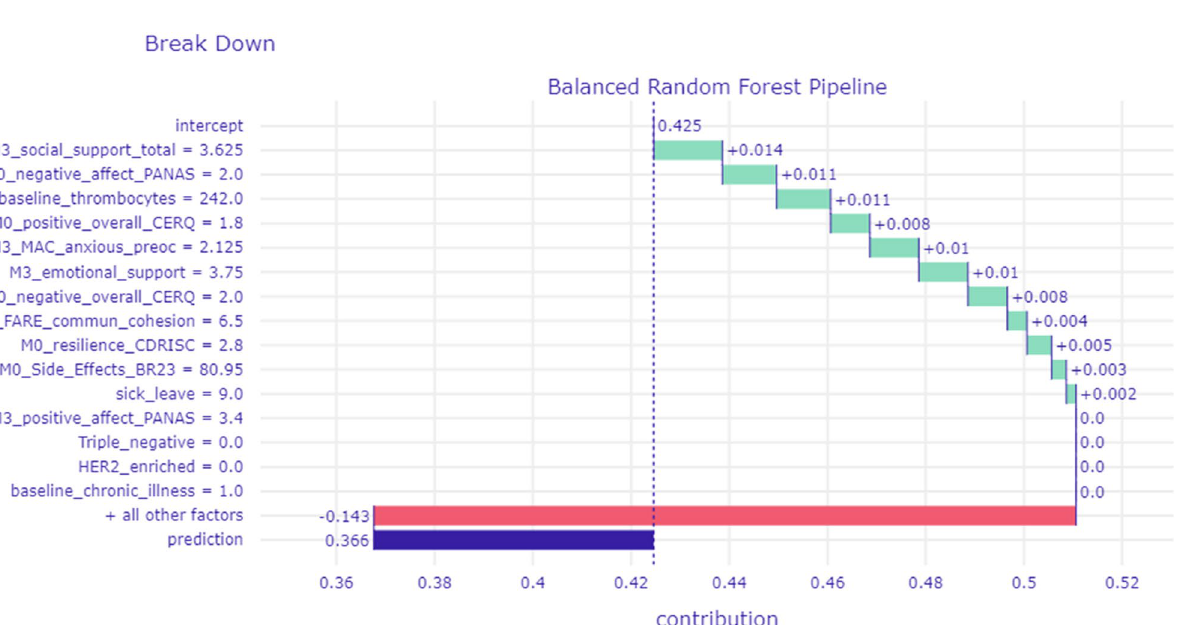
Figure 3. BD profile of a patient who displayed stable good mental health status as indicated by a very low probability of membership in the Deteriorated Mental Health class (0.366). All other figure elements are the same as in Fig.